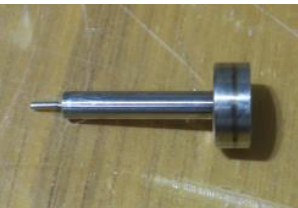
Fig. 1. View of a fissile target: a miniature fission chamber with a flat fissile deposit (8 mm in diameter) coated on its inner electrode.